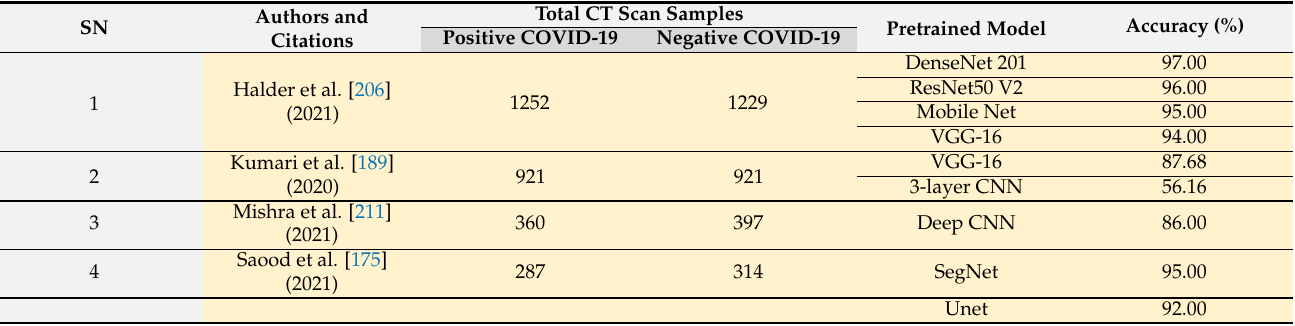
Figure 13. Manual lesion delineation overlays (red) from tracer 2 on raw CT lung images (Courtesy of AtheroPoint™, Roseville, CA, USA permission granted). Table 4. Pretrained models for